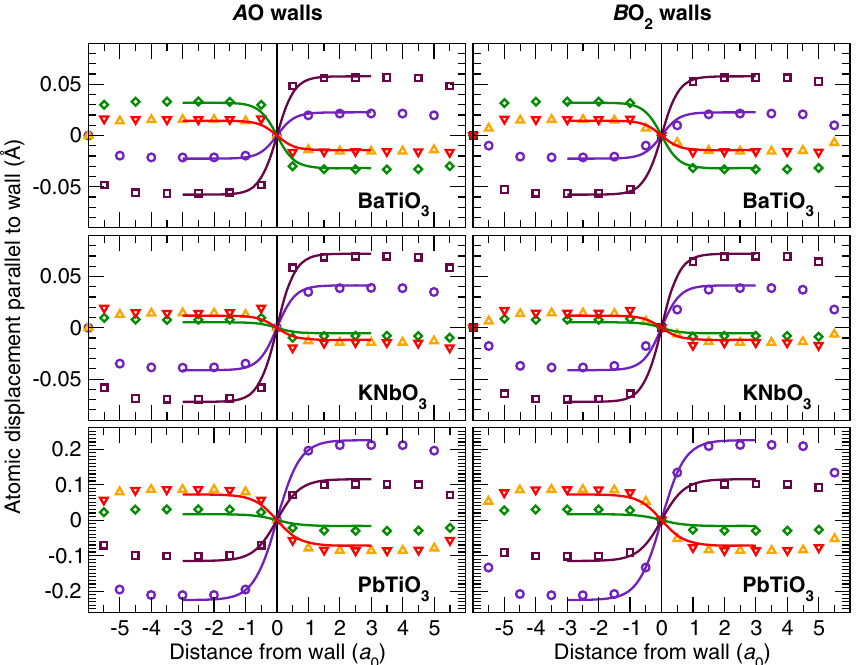
FIG. 3. Empty symbols: relaxed displacements of the atoms in the direction parallel to the domain wall as a function of the normal coordinate, extracted from full DFT calculations (circles, squares, diamonds, and triangles represent, respectively, A , B , apical O, and equatorial O atoms). Continuous curves: atomic displacement profiles predicted by the Landau model. Two possible types of domain wall (either A O- or B O 2 -centered) are shown for three of the six perovskites considered in this